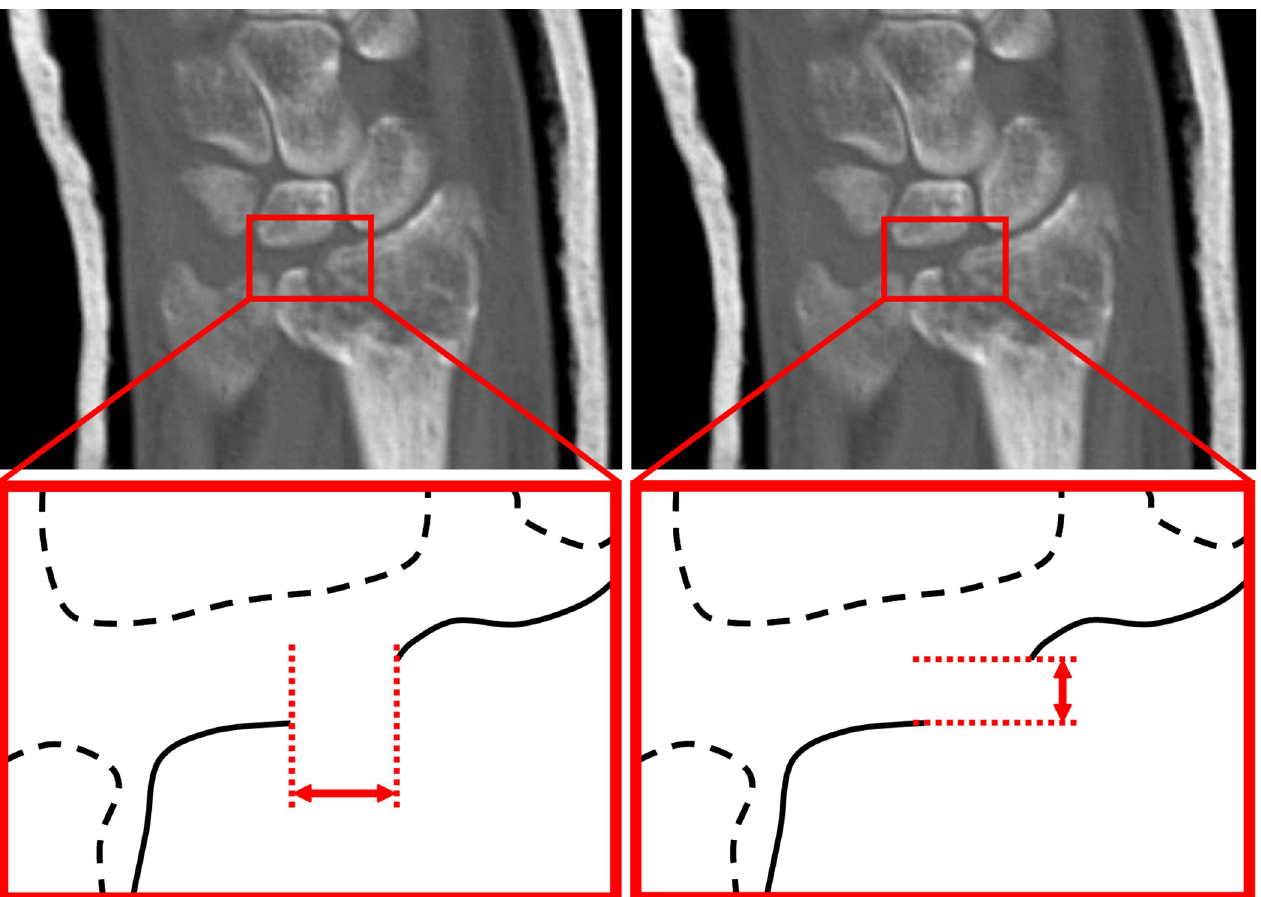
Fig 3. Coronal CT-slice of the wrist of patient 1 with a schematic representation of gap and step-off measurements. Left image: Measurement of the 2D gap (3.6 mm). Right image: Measurement of the 2D step-off (1.6 mm).